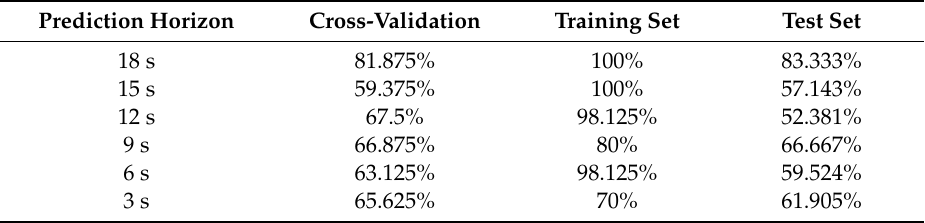
Table 1. Prediction accuracy for di ff erent prediction